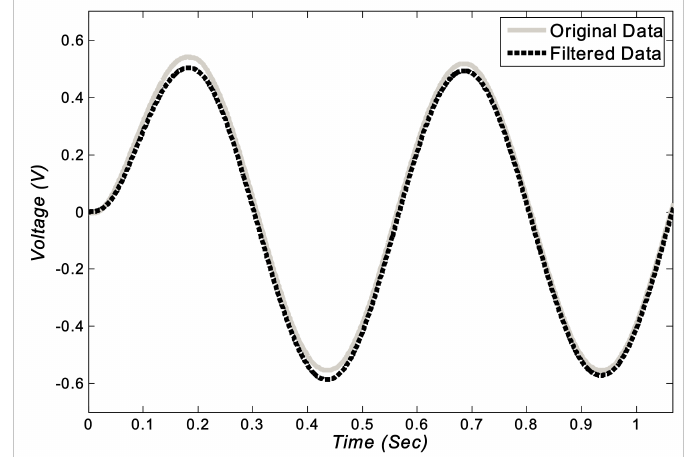
Figure 17. Comparison of the derivatives of the original and filtered input voltages for Amp = 20 mm and Freq = 2 Hz.